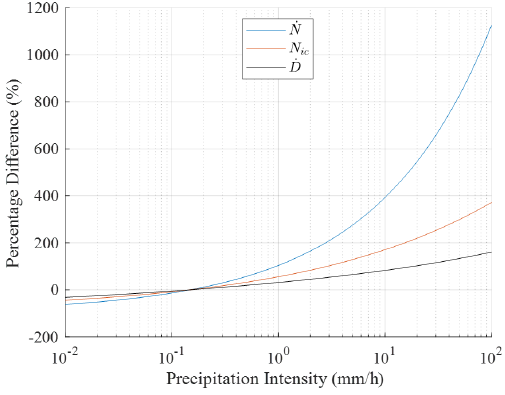
Figure 12. Percentage change in leading edge erosion damage val- ues from implementing the offshore DSD relative to implementing the Best